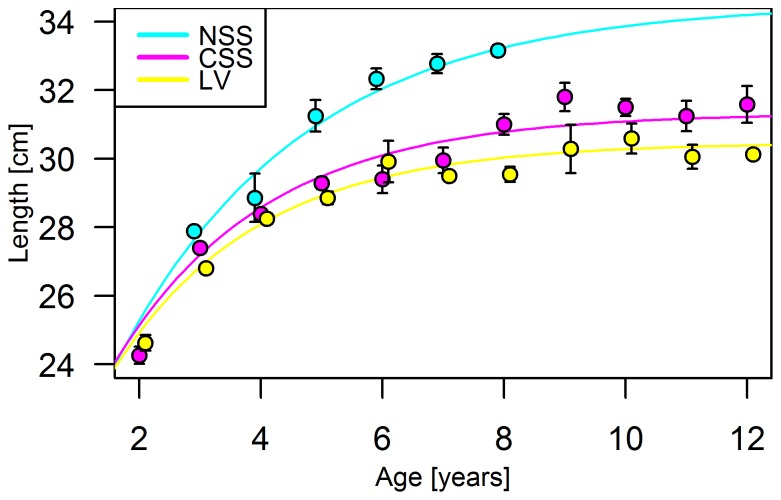
Growth curves of different herring populations.Length-at-age for Norwegian spring spawning (NSS, N = 212), Coastal Skagerrak spring spawning (CSS, N = 667) and Landvik (LV, N = 371) herring in samples pooled over the 2012 spawning season. Means and standard error (1 SE) are given, lines show van Bertalanffy growth models fitted to data.